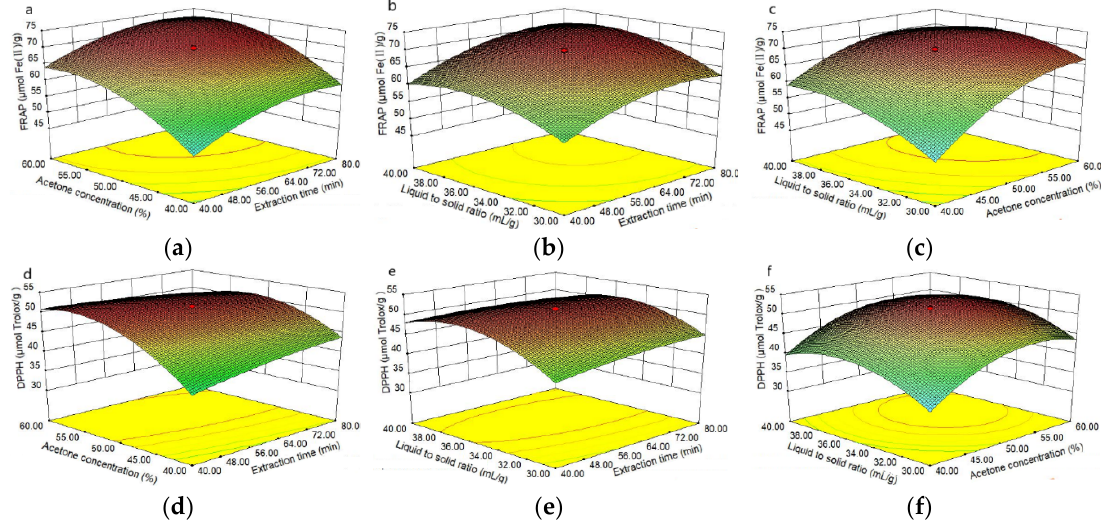
Figure 2. 3D response surface curve and corresponding contour plot showing the effects of independent variables of ultrasonic treatment on DPPH and FRAP. ( a ) Mutual effects of acetone concentration and extraction time on FRAP; ( b ) mutual effects of liquid-to-solid ratio and extraction time on FRAP; ( c ) mutual effects of acetone concentration and liquid-to-solid ratio on FRAP; ( d ) mutual effects of acetone concentration and extraction time on DPPH; ( e ) mutual effects of liquid-to-solid ratio and extraction time on DPPH; ( f ) mutual effects of acetone concentration and liquid-to-solid ratio on DPPH.